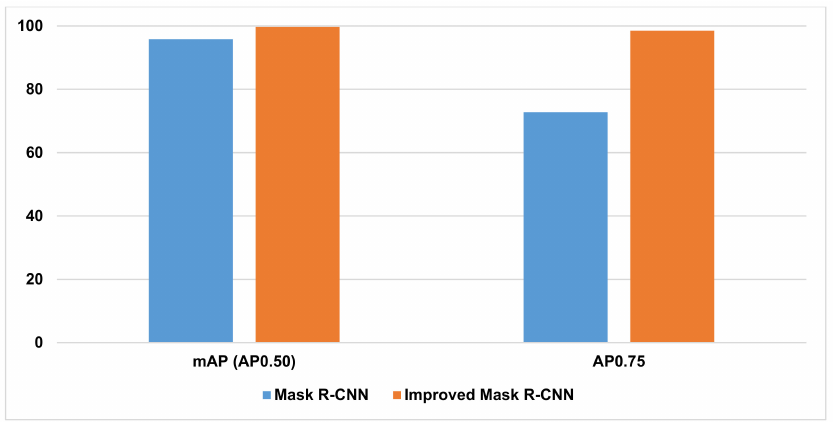
Figure 13. Results of mAP when AP = 0.50 and AP = 0.75 for the testing dataset after applying default and improved Mask R-CNN.